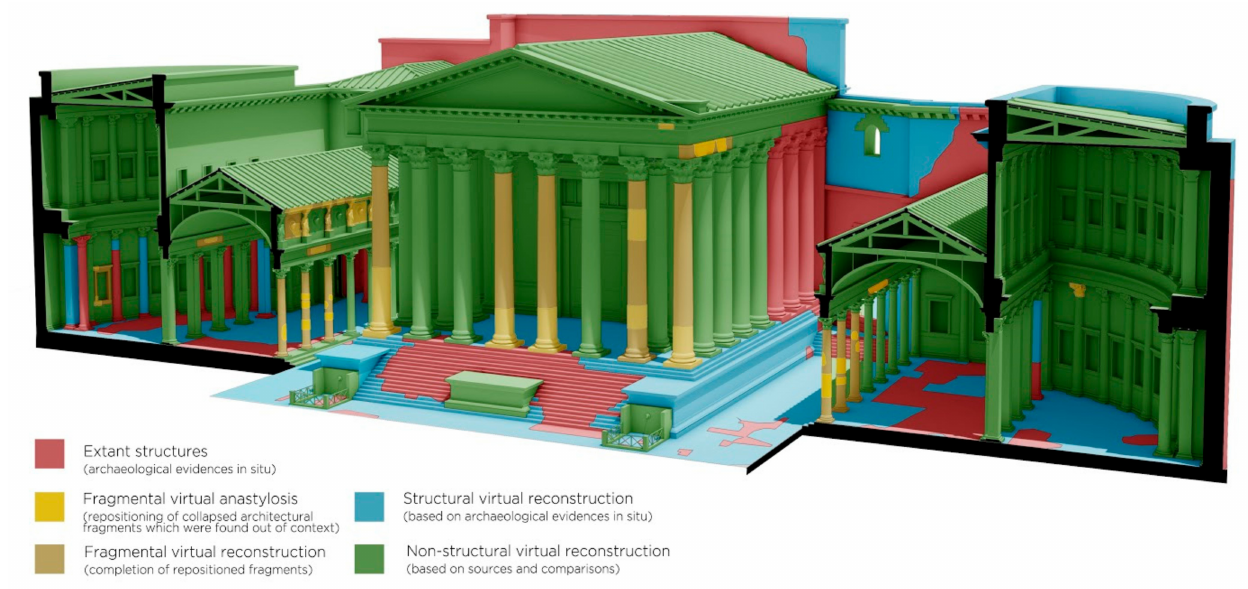
Figure 14. Virtual reconstruction of the forum rendered in coded colors, mapping the levels of reliability.